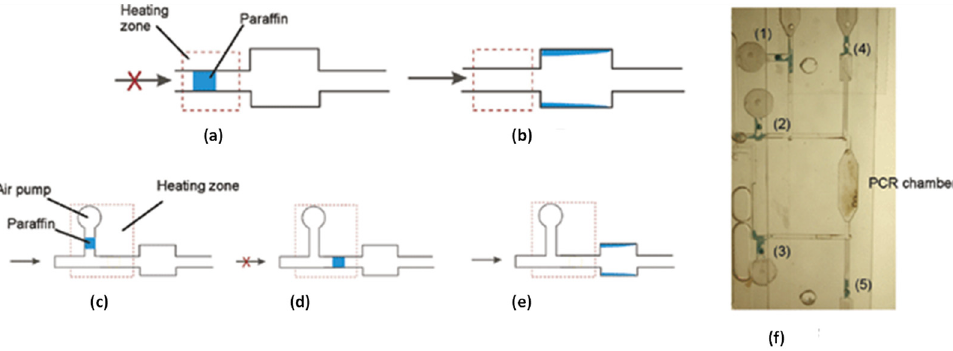
Figure 11. Schematic illustrations of a close–open paraffin microvalve design ( a , b ) and an open–close–open microvalve design ( c – e ). The former has a block of paraffin that initially closes the channel ( a ). To open the channel, the paraffin is melted using the heater underneath and moved downstream by the pressure from the upstream channel. Once the molten paraffin moves out of the heating zone, it starts to solidify on the wall of a wide channel section resulting in an open channel ( b ). The latter is a normally open valve with a block of paraffin connected to an air pocket that acts as a thermally actuated air pump ( c ). When the heater is activated, the air in the pocket expands and pushes the molten paraffin into the regulated channel. If the heater is turned off immediately, the paraffin solidifies in the main flow channel, resulting in a closed channel ( d ). The channel can be reopened by reactivating the heater ( e ). A photograph ( f ) of the PCR chamber surrounded by five paraffin ‐ based microvalves: valves 1 − 3 are open − close valves, and valves 4 and 5 are close − open valves. All valves are in “closed” position prior to initiating PCR. The PCB that provides thermal actuation to the valves is not shown here. Purified E. coli − bead complexes (brown) are retained in the PCR chamber. Permission granted by the publisher [58].